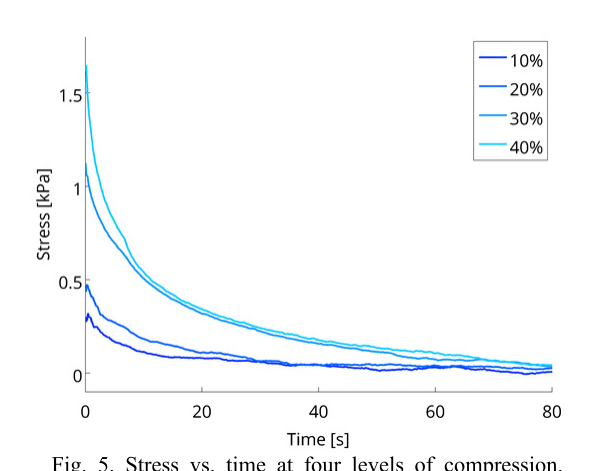
Fig. 5. Stress vs. time at four levels of compression. Using a standard moving average fitting technique the stress measurements were smoothed out and averaged within compression levels (n = 12). The initial time is set to the moment when the linear stage ceases to compress the samples.